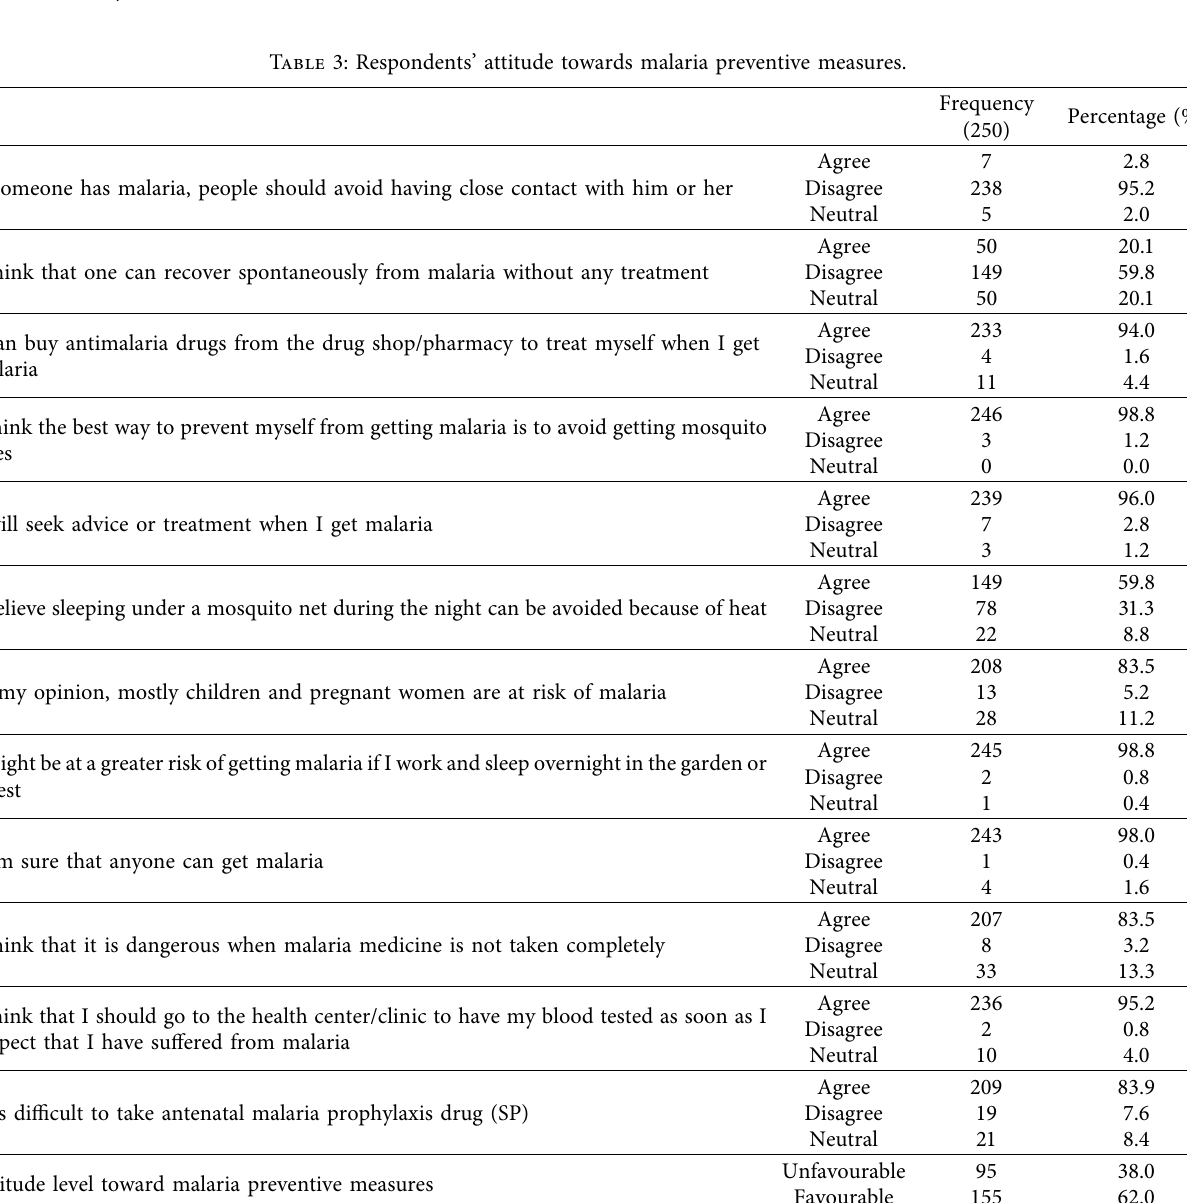
Table 3: Respondents’ attitude towards malaria preventive